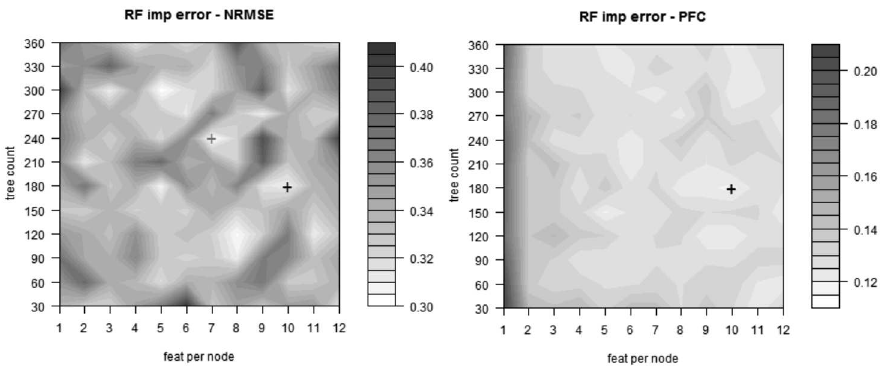
Figure 3. Results of tuning missForest imputation algorithm parameters